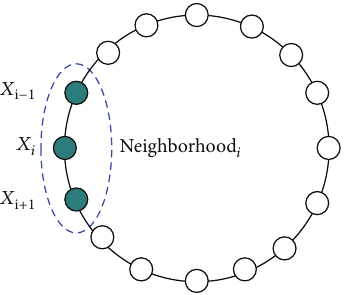
Figure 2: Ring neighborhood topology with three